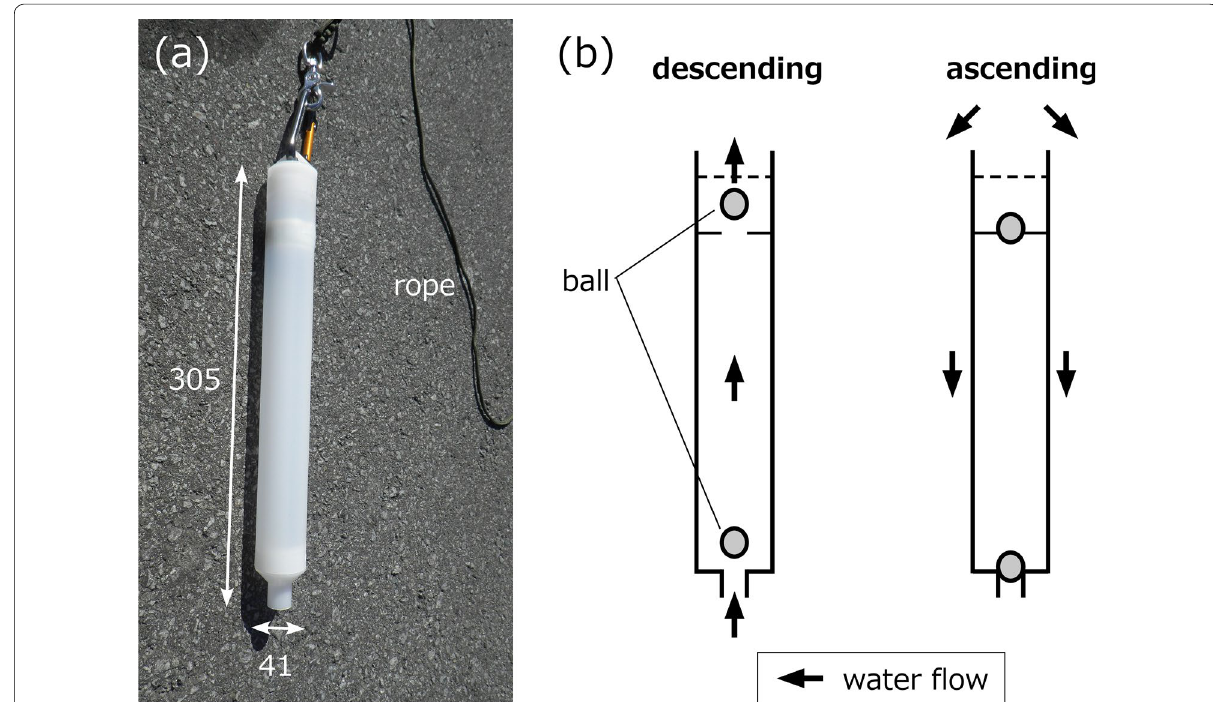
Fig. 3 Photograph and schematic illustrations of the water sampling bottle. a Photograph of the water sampling bottle, and b schematic illustra- tions of the bottle. Numbers in panel a represent dimensions in